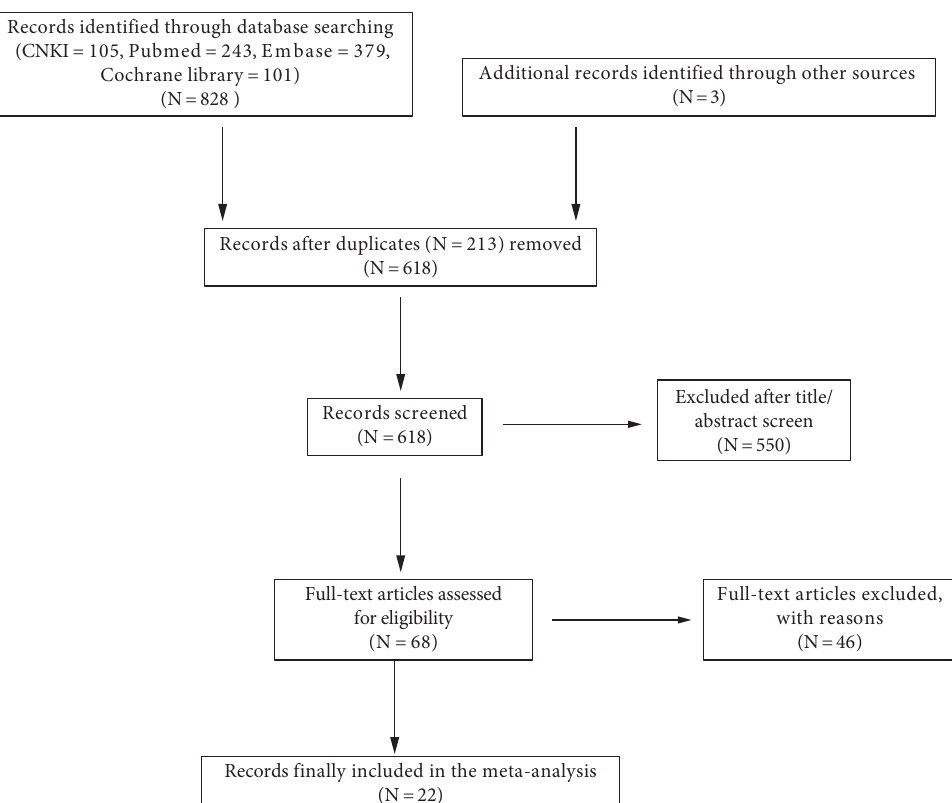
Figure 1: Flow chart of study